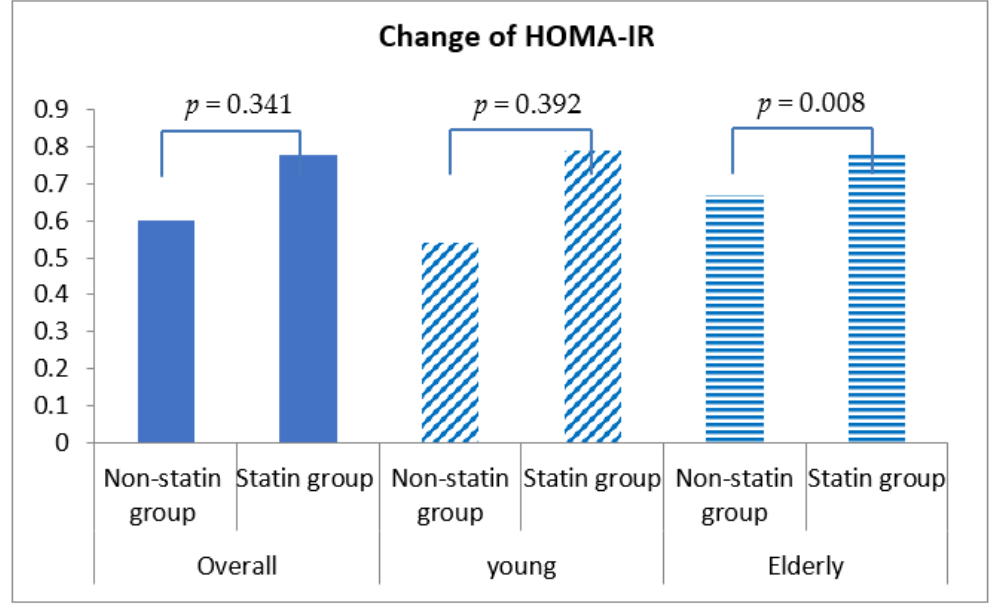
Figure 4. Changes in homeostasis model assessment insulin resistance (HOMA-IR) index among non-statin and statin users overall and in young and elderly patients after propensity score matching.